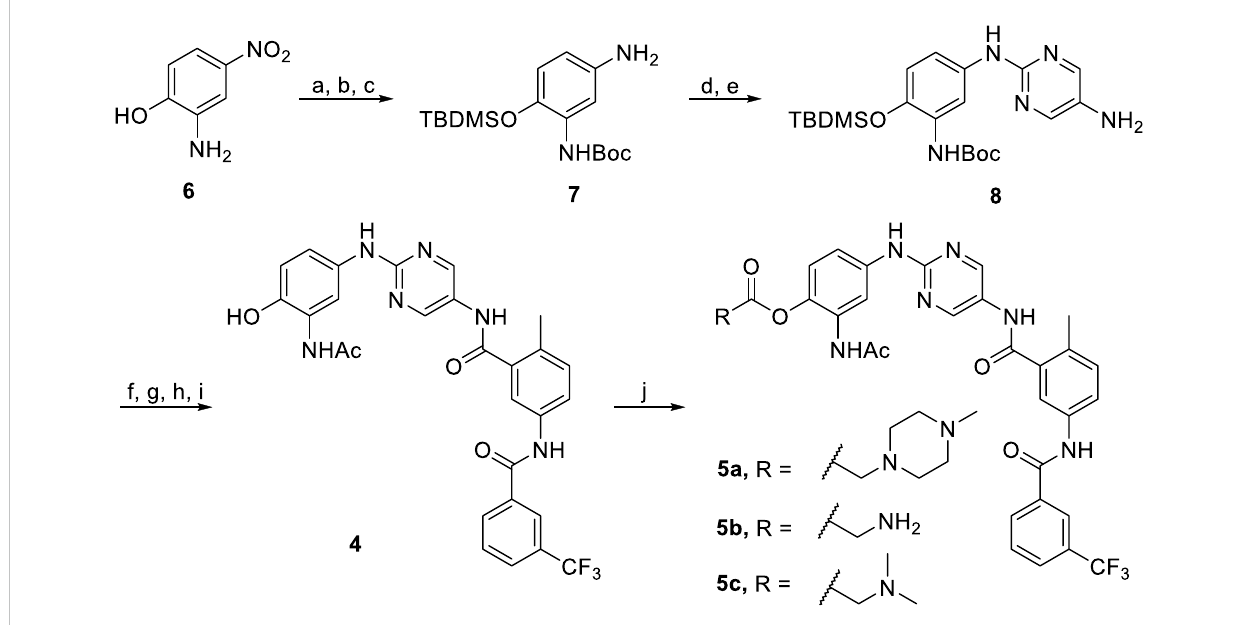
SCHEME 2 Reagents andconditions: (a)(Boc) 2 O,EtOH,rt,12 h,63%;(b)Pd/C,H 2 ,MeOH,rt,12 h,90%;(c)TBDMSCl,DIEA, CH 2 Cl 2 , rt,3h,67%;(d)2-Chloro-5- nitropyrimidine,